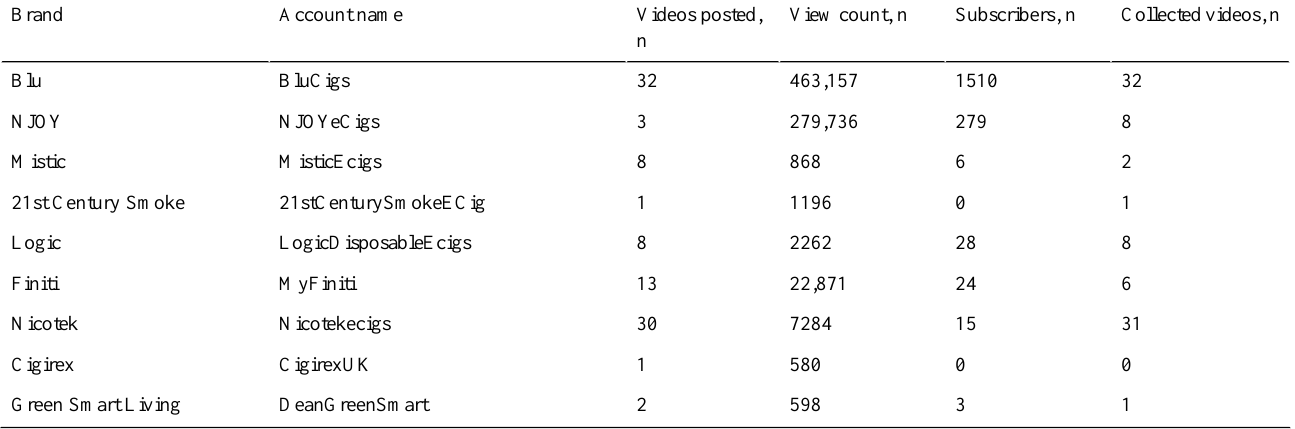
Table 4. YouTube account activity for top-selling e-cigarette brands as of June 30,